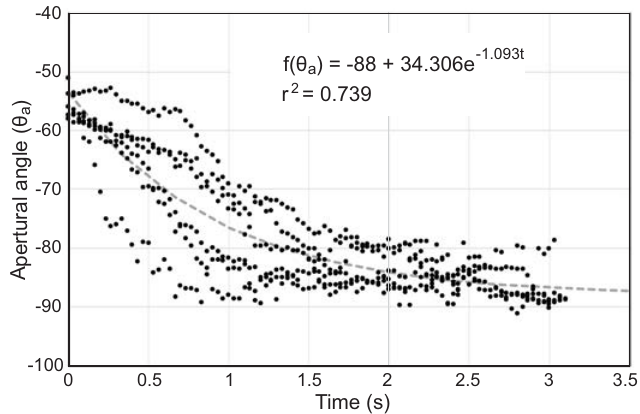
Fig. 10. Hydrodynamic restoration of the Baculites compressus 3D printed model following overdamped harmonic motion. Apertural angle ( θ a ) mea- sured in degrees as a function of time after rotating approximately 38° from the equilibrium orientation. An angle of -90° represents a condition where the aperture is directed downwards. The function of decay in θ a with time is represented by the grey dashed curve. Note that this model restores more quickly and does not oscillate about the equilibrium